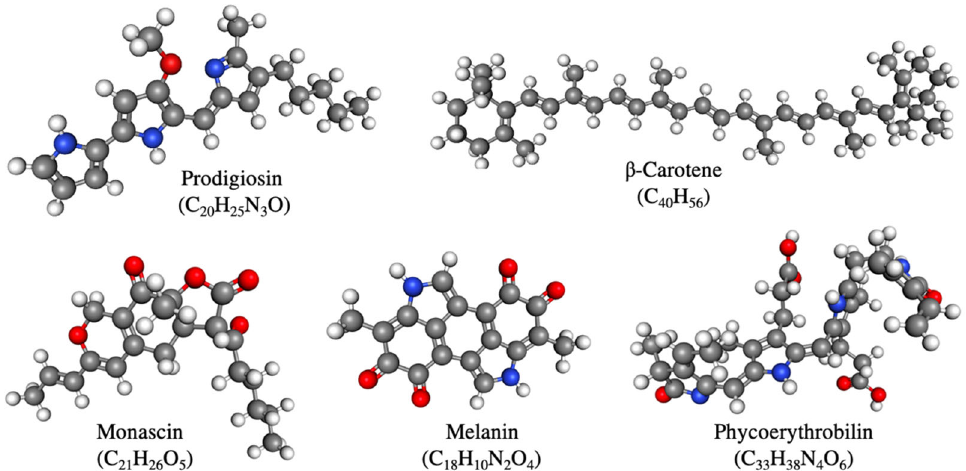
Figure 1. The 3D chemical structures of industrially important microbial pigments. Images are drawn in MolView online program (https://molview.org/, accessed on 4 July